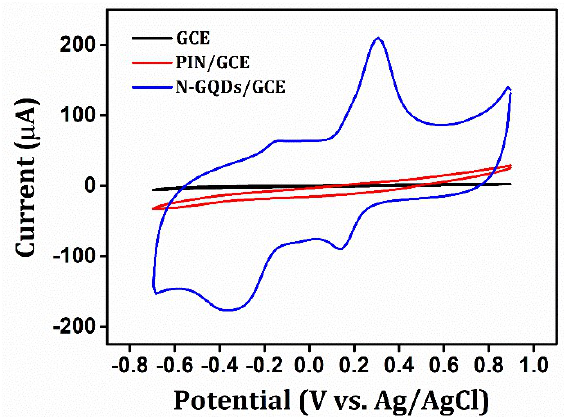
Figure 4. Comparison of CV scans obtained for GCE, PIN/GCE, and N-GQDs/GCE for 0.1 mM DA in 0.1 M PBS at 100 mV s −1 .